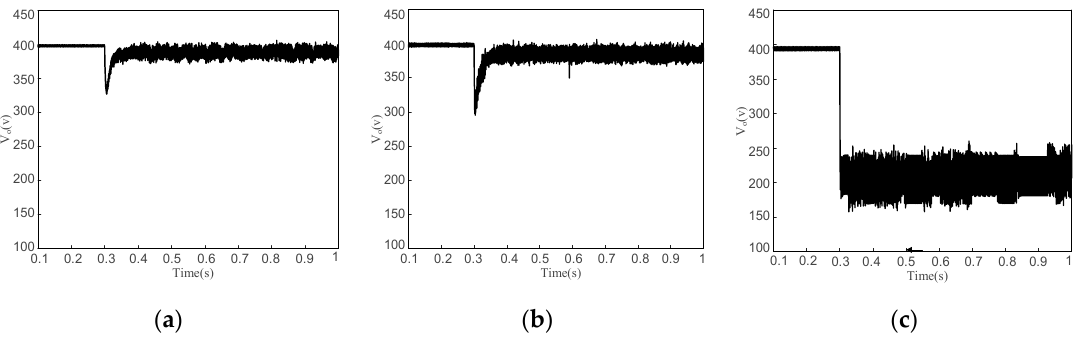
Figure 7. Waveforms of the DC bus voltage in case of ( a ) P CPL changes to 25,400 W; ( b ) P CPL changes to 34,300 W; ( c ) P CPL changes to 36,100 W.